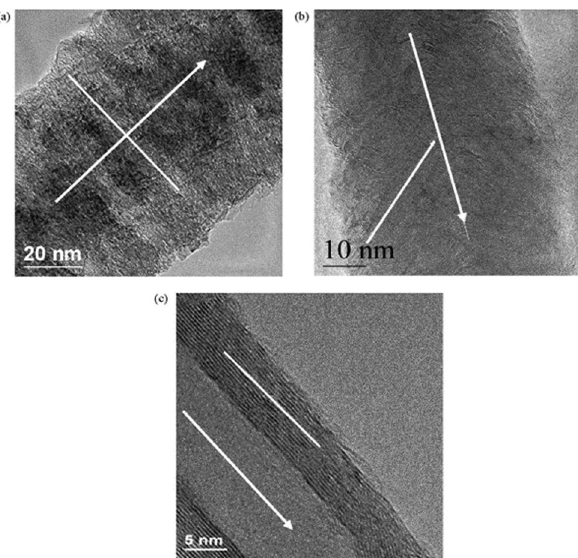
Figure 2: High - resolution transmission electron microscope image of ( a ) platelet CNF, ( b ) fi sh - bone CNF, and ( c ) tubular CNF [ 58 – 60 ]